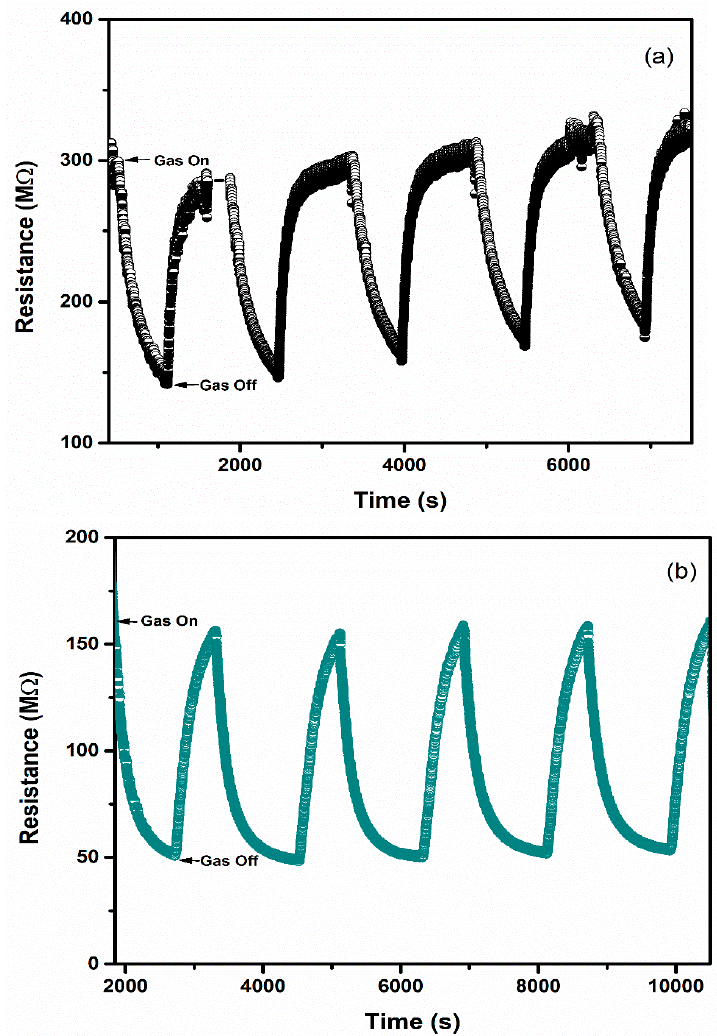
Figure 9. Repeatable sensing characteristics of ( a ) WO 3 ( b ) 1% Ag–WO 3 at 5 ppm NH 3